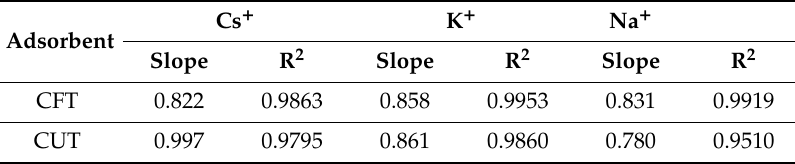
Table 1. Calculated slope value of alkali metal ions based on the equations. Cs + K + Na + Adsorbent Slope R 2 Slope R 2